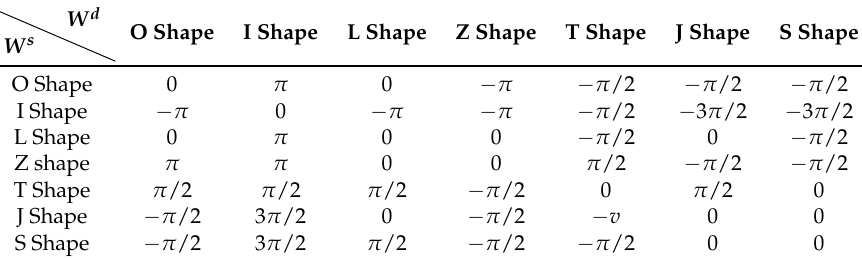
Table 4. Orientation offset ϕ s , d to next Destination waypoint W d